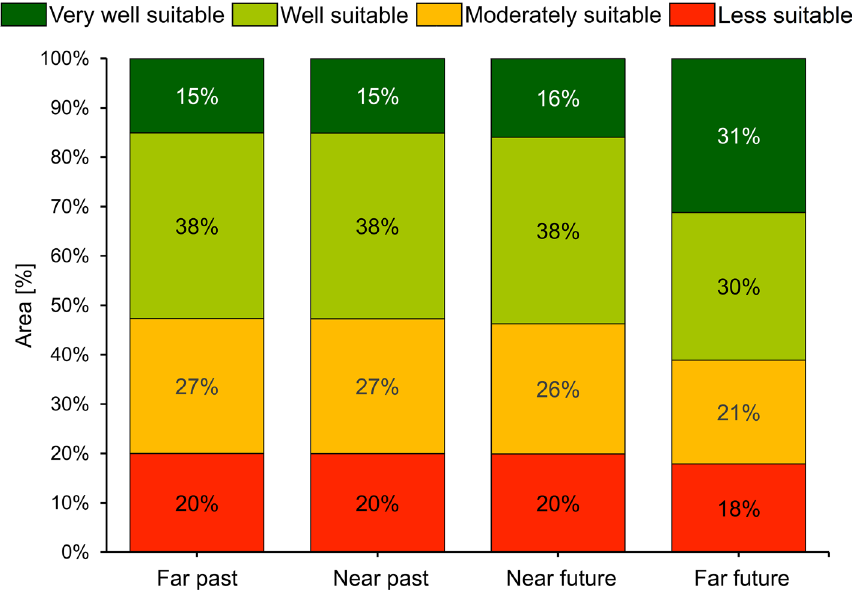
Fig. 6 Percentage shares of ATES suitability potential classes in Germany for the four considered time periods far past (1961–1990), near past (1991–2020), near future (2021–2050) and far future (2071–2100) . The shares refer to the parts of Germany that are not covered by hard rock or inland water